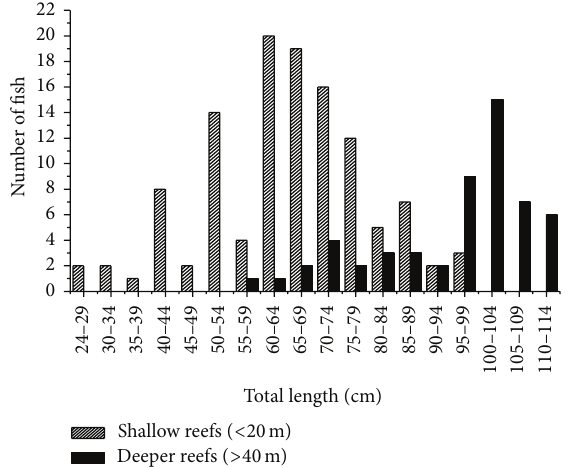
Figure 7: Number of Epinephelus malabaricus caught by small scale fishers at different reef depth profiles around Mafia Island between September 2009 and December 2010.